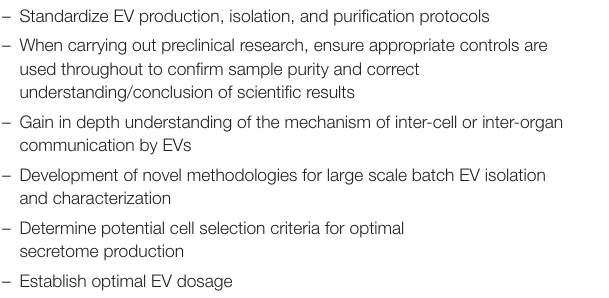
TABLE 2 | Developments required to take EVs forward to clinical